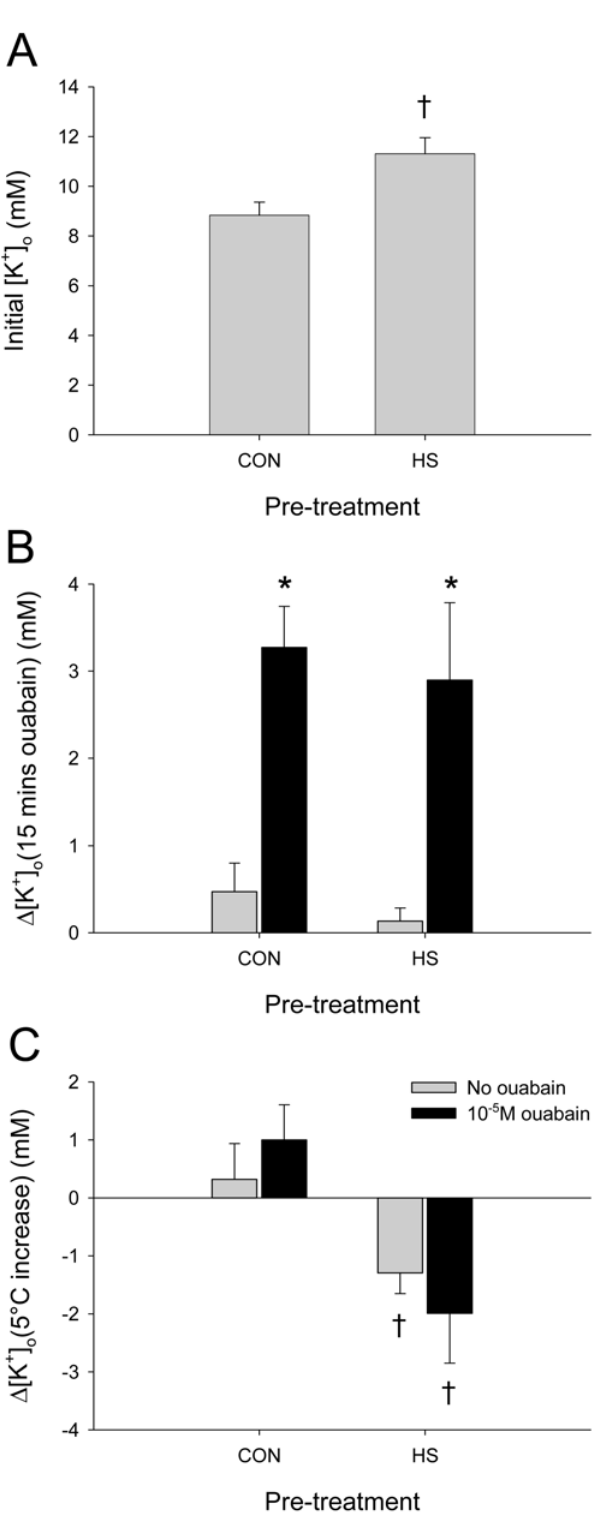
Figure 6. HS and ouabain affect [K + ] o . A. Heat shock preconditioning resulted in a significantly higher [K + ] o in HS locusts compared to CON locusts. All animals pooled: N CON =25; N HS =26. B. CON-OUA and HS- OUA locusts had a significantly greater increase in [K + ] o after 15 minutes of bath application with 10 2 5 M ouabain compared to CON and HS locusts. HS pre-treatment did not have an effect on D [K + ] o over this 15 minute period (N CON = 12; N CON-OUA = 10; N HS =